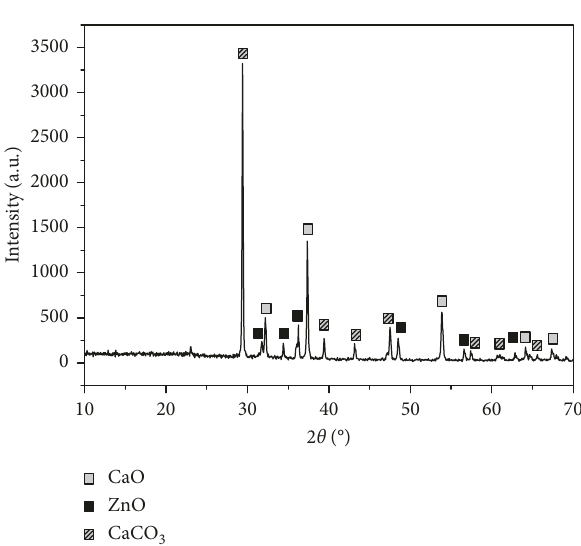
Figure 3: XRD diffractogram of the CaO-ZnO catalyst.